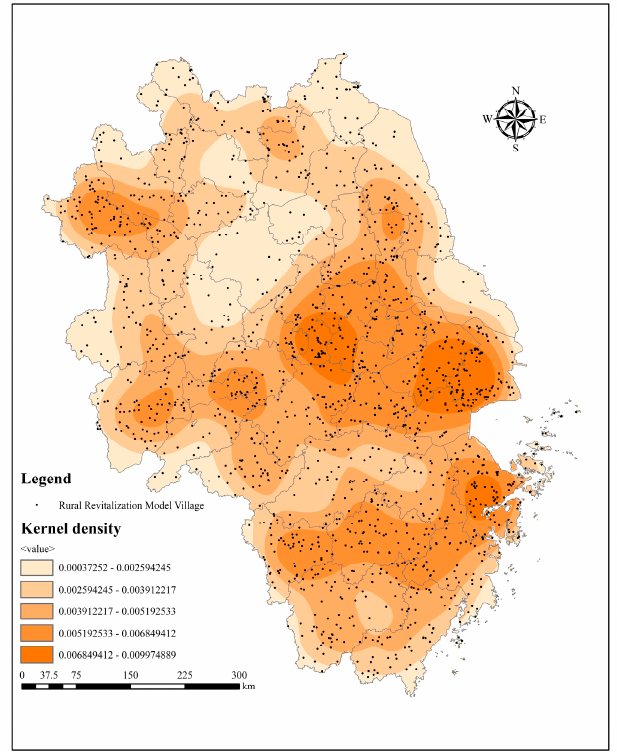
Figure 3. Kernel density map of rural revitalization model villages in the YRD.